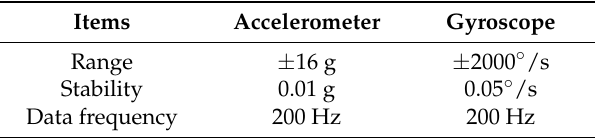
Figure 2. Applied equipment. ( a ) Installation method; ( b ) Exterior.